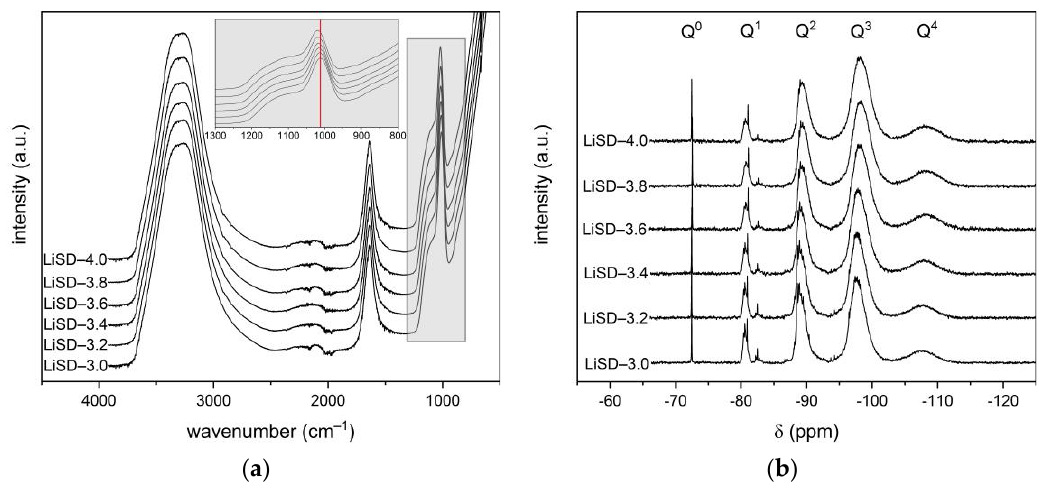
Figure 1. ( a ) FT-IR spectra; ( b ) NMR spectra of studied lithium silicate densifiers. Table 2. Distribution of Q n silicate units determined by 29 Si-NMR spectra in lithium silicate densifiers.